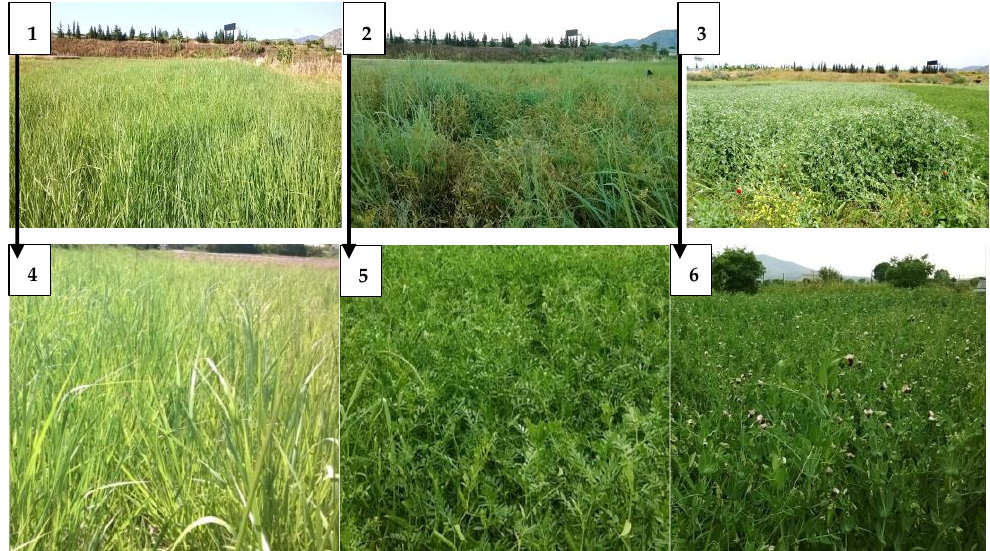
Figure 3. S 1 : switchgrass as monoculture ( 1 , 4 ), S 2 : switchgrass with vetch ( 2 , 5 ), S 3 : switchgrass with pea ( 4 , 6 ). In all cases, switchgrass is in the growing stage of 5 – 6 leaves.